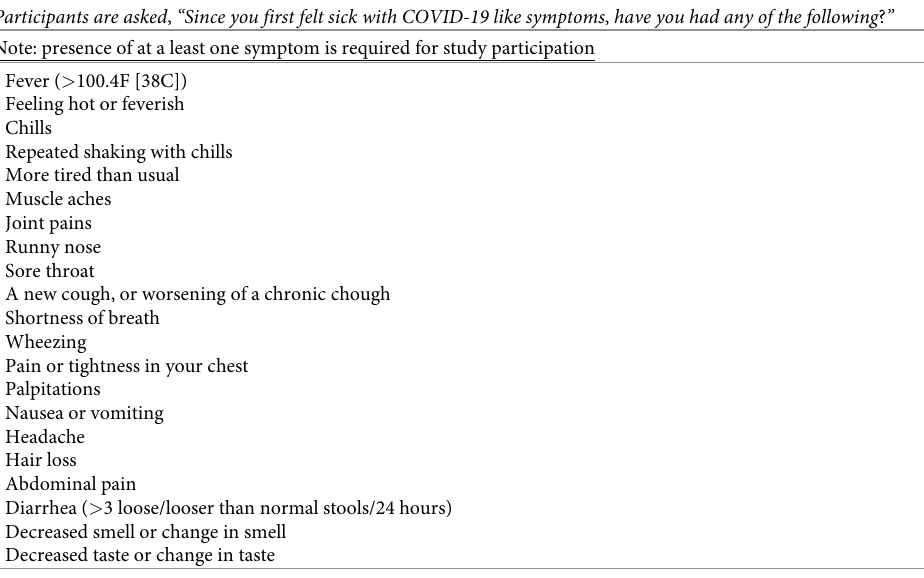
given the anticipated lower rates of outcomes among asymptomatic individuals who test posi- tive for SARS-CoV-2, and the significant heterogeneity in reasons for testing in asymptomatic individuals, such as screening for social, educational, occupational reasons and prior to routine clinical procedures. Individuals who self-report symptoms suggestive of acute SARS-CoV-2 infection, and are tested for SARS-CoV-2 within the last 42 days, are eligible to participate. From study initiation through the summer of 2021, symptoms of acute SARS-CoV-2 were defined using the COVID-19 clinical criteria case definition [18]; beginning August of 2021, in order to capture less symptomatic individuals, the inclusion criteria were revised to require only one symptom among those listed in Table 2. Individuals for whom a SARS-CoV-2 test result cannot be confirmed are not eligible to participate in the study. Efforts are made to recruit participants from across the spectrum of COVID-19 illness severity, including individ- uals from outpatient (e.g., drive through testing with self-reported symptoms) to inpatient set- tings, and those cared for in intensive care units. We initially used a 3:1 case/control enrollment ratio to oversample those who are positive for SARS-CoV-2 on testing, while still Table 2. List of COVID-19 like symptoms used to determine study enrollment eligibility. Participants are asked , “Since you first felt sick with COVID-19 like symptoms , have you had any of the following ? ” Note: presence of at a least one symptom is required for study participation